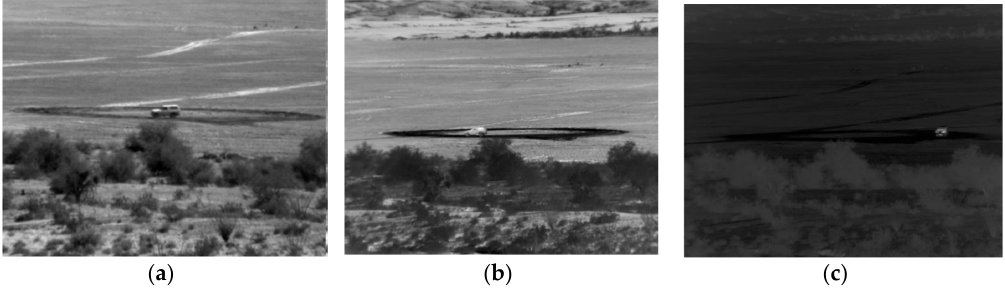
Figure 5. Frames from optical and MWIR videos. Although the videos were collected from roughly the same range, the vehicle sizes and characteristics are somewhat different, making the tracking and classification very difficult. Three scenarios are shown: ( a ) Optical at 1000 m; ( b ) MWIR daytime at 1000 m; and ( c ) MWIR nighttime at 1000 m.